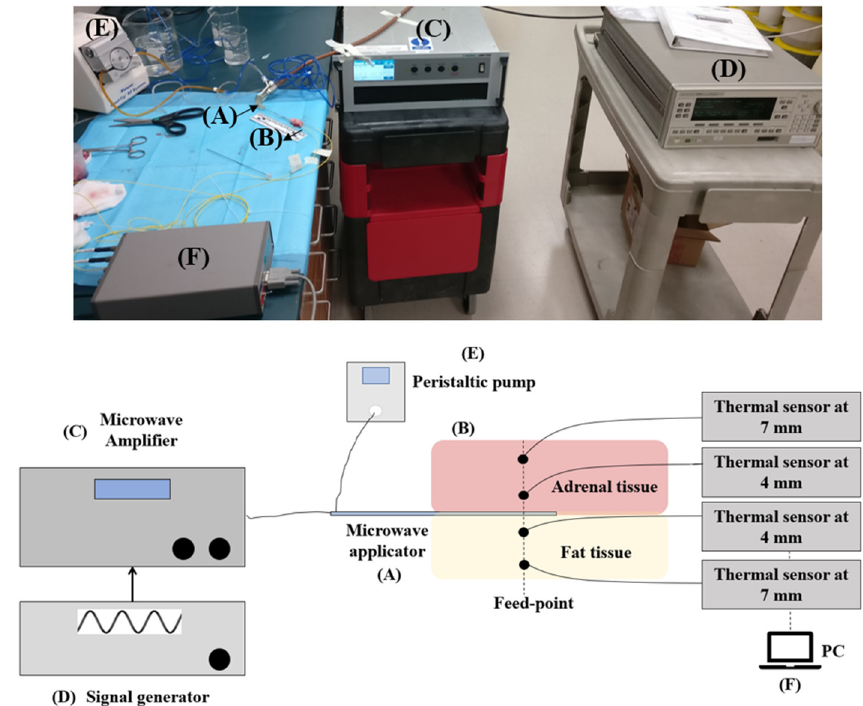
Figure 2. Setup adopted for the experimental validation of the computational results ( top ) and related schematization ( bottom ). The setup includes the microwave applicator ( A ) placed in the tissue (B) and powered for 60 s at the input power provided by the microwave amplifier ( C ) which amplifies the signal at the designed operating frequency ( D ); a peristaltic pump ( E ) connected to the inflow and outflow tubes of the refrigerating system integrated in the applicator; four fiber optic sensors connected to a laptop ( F ) to acquire values of temperature at 0.1 s time step.